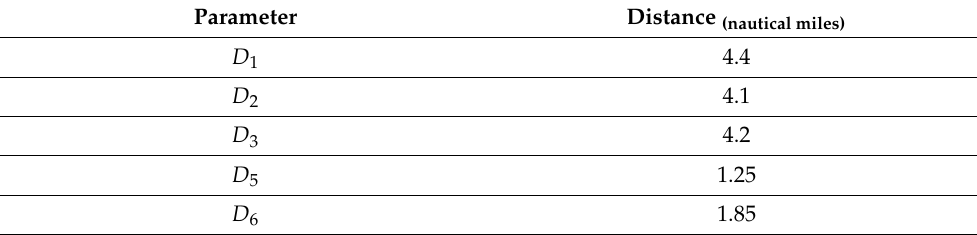
Table 4. Distance